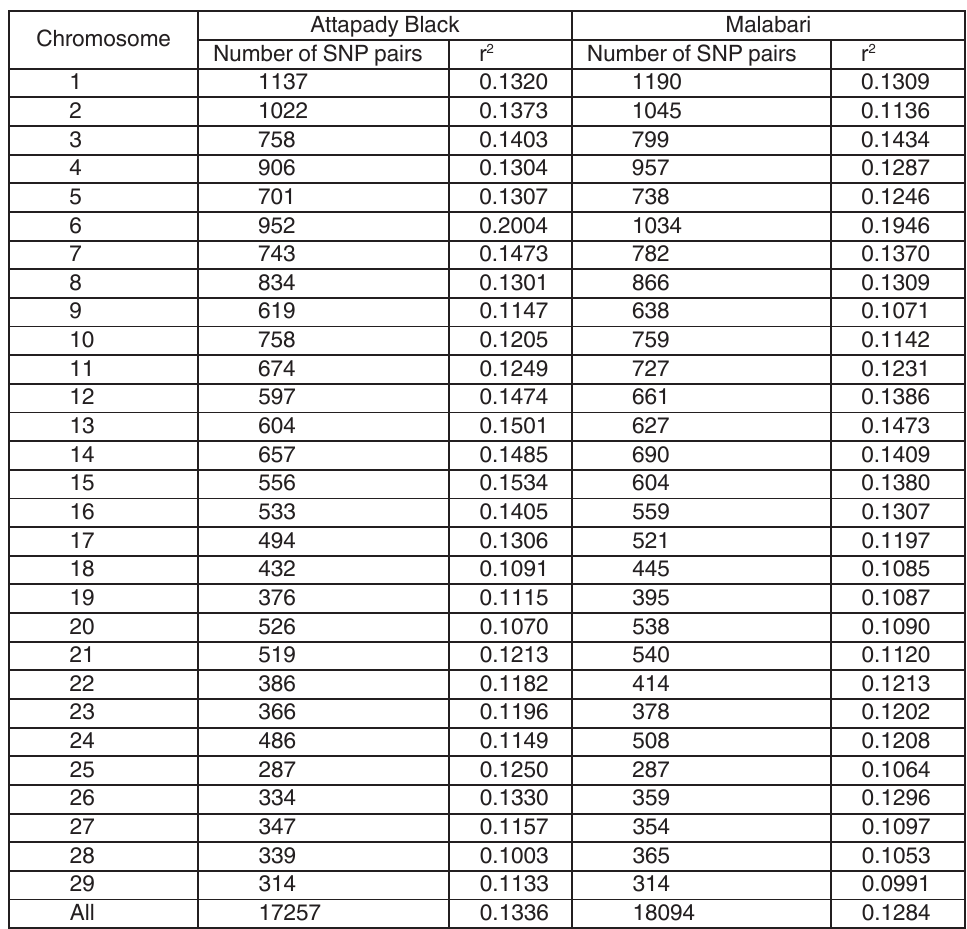
table 1. Average linkage disequilibrium (LD, r 2 ) in different autosomal chromosomes for Single nucleotide polymorphisms (SNP) pairs within 40 kb interval in Attapady Black and Malabari goats of